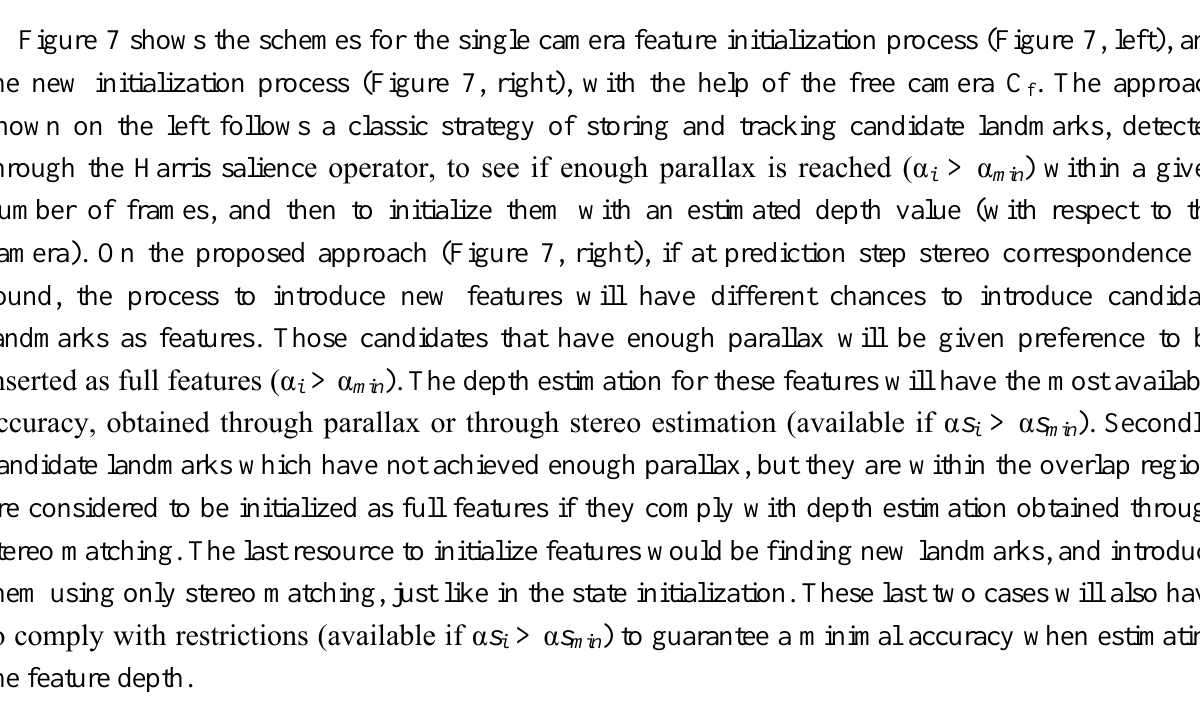
Figure 7. Feature initialization process according to the single monocular camera approach ( left ) and the proposed method with non-constant stereo I-D feature initialization ( right